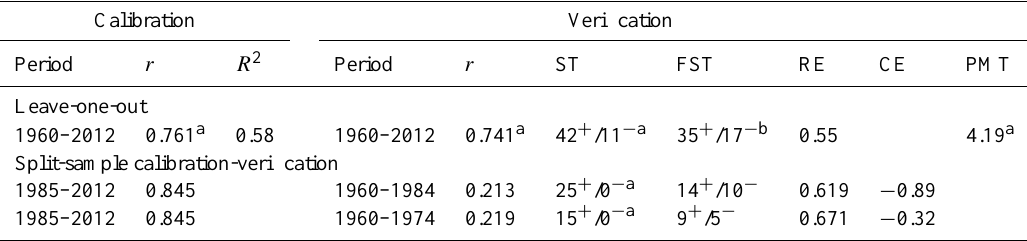
Table 3. Leave-one-out statistics and split-sample verification for the reconstructed January–August T min for the common period of 1960– 2012.